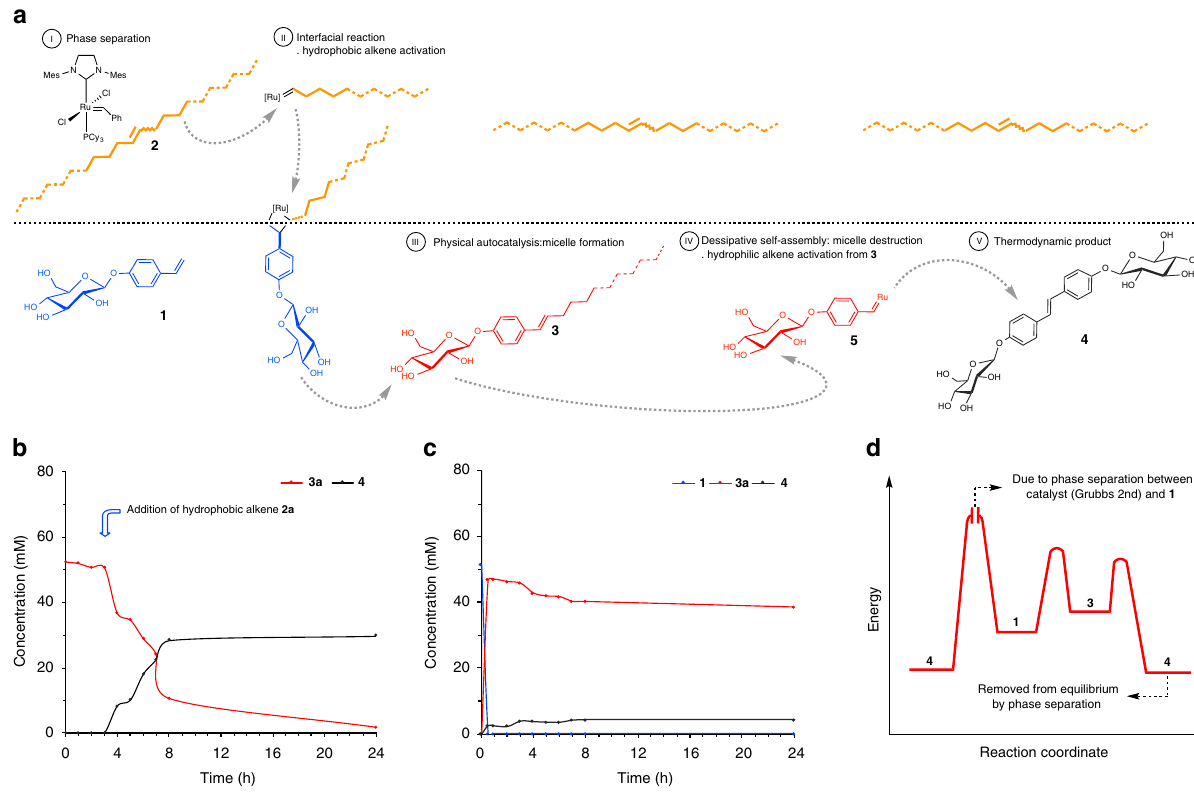
Fig. 4 Mechanistic hypothesis supported by control experiments. a Diagram of the dynamic system including the chemical structures involved. Kinetic analysis representing concentration vs. time of 1 (blue), 3a (red) and 4 (black) for the control experiments: b In D 2 O replicator 3a is stable. It is only on addition of alkene 2a that it is fully consumed to form waste product 4 . c In reaction between 1 and 2a performed under homogeneous conditions no autocatalytic kinetics are observed for the formation of 3a . Under these conditions product 3a appears to be relatively stable. d Qualitative energy pro fi le of the system, highlighting the higher effective barrier for direct conversion of 1 to 4 under phase separated conditions. Phase separation may shift the equilibrium position between 3a and 4 by effectively removing water soluble 4 from the micellar